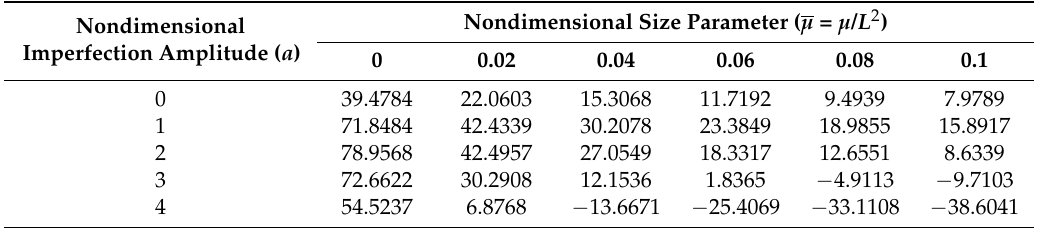
Table 2. Non-dimensional buckling load for a variety of initial curvatures and size parameter for a = 2. Nondimensional